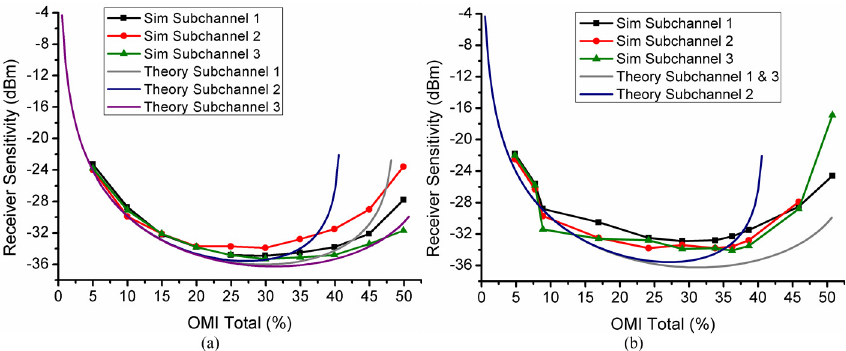
Figure 2. Simulated and theoretical best achievable optical receiver sensitivities for ( a ) the SCM/SSB frequency plan consisting of three 2.7 Gbaud QPSK subchannels and ( b ) the OSCM/SSB frequency plan consisting of three orthogonally overlapping 2.7 Gbaud QPSK subchannels. The values employed in the simulation and the theoretical calculations are: N = 3, F = 5 dB, v = 193.4 THz (1550 nm), Q F = 2.67 (BER = 3.8 × 10 − 3 ), B = 2.7 GHz, and intermodulation product count according to Table